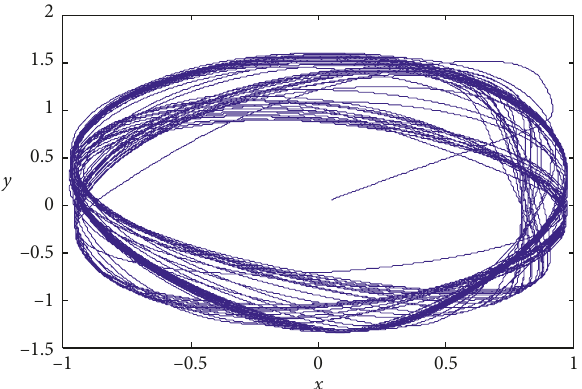
Figure 10: Orbits at the position of pedestal looseness (looseness clearance